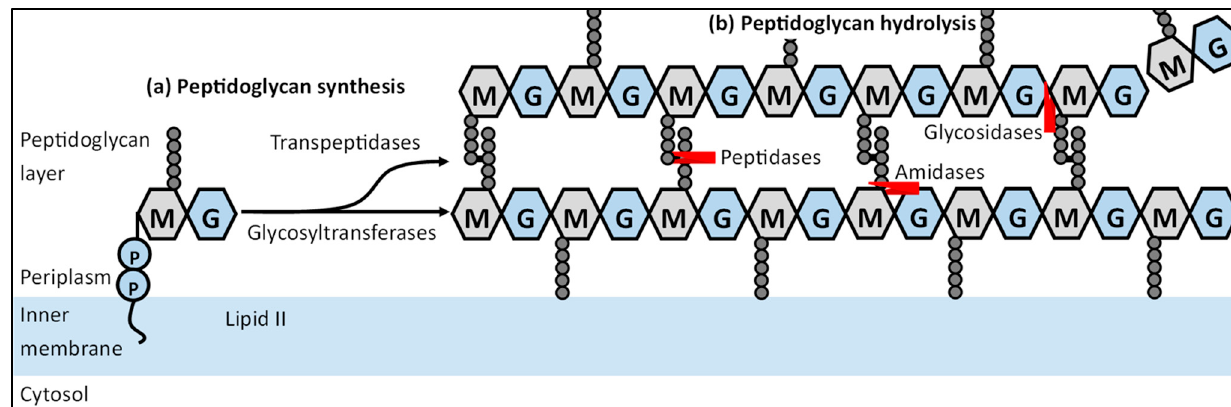
Figure 2. Peptidoglycan biosynthesis and remodeling. This simplified scheme describes the steps needed to synthesize new peptidoglycan from precursor Lipid II that is synthesized in the cytoplasm. Lipid II is then flipped to the periplasmic side of the inner membrane by a flippase, where the synthesis of peptidoglycan occurs. ( a ) Lipid II is incorporated in an already growing peptidoglycan strand by glycosyltransferases. Adjacent Peptidoglycan strands are crosslinked by transpeptidases through the pentapeptides attached to the NAM residues, resulting in a peptidoglycan mesh. ( b ) Factors involved in the remodeling of the peptidoglycan mesh are PG hydrolases, which can be divided in multiple groups based on their targets. Peptidases cleave amide bonds in the cross-linked peptide chains, amidases cleave off the peptide chains attached to NAM residues and glycosidases that hydrolyze the glycosidic linkage between adjacent NAG and NAM residues.